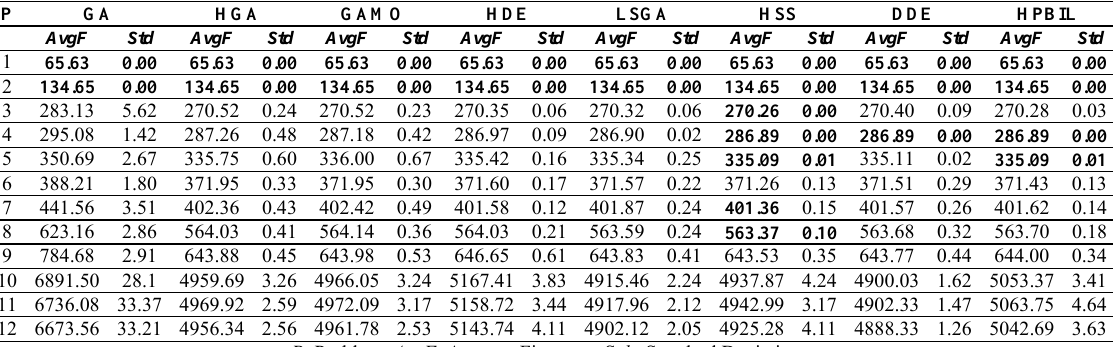
Table 5. Results – Evolutionary Algorithms – Average Fitnesses and Standard